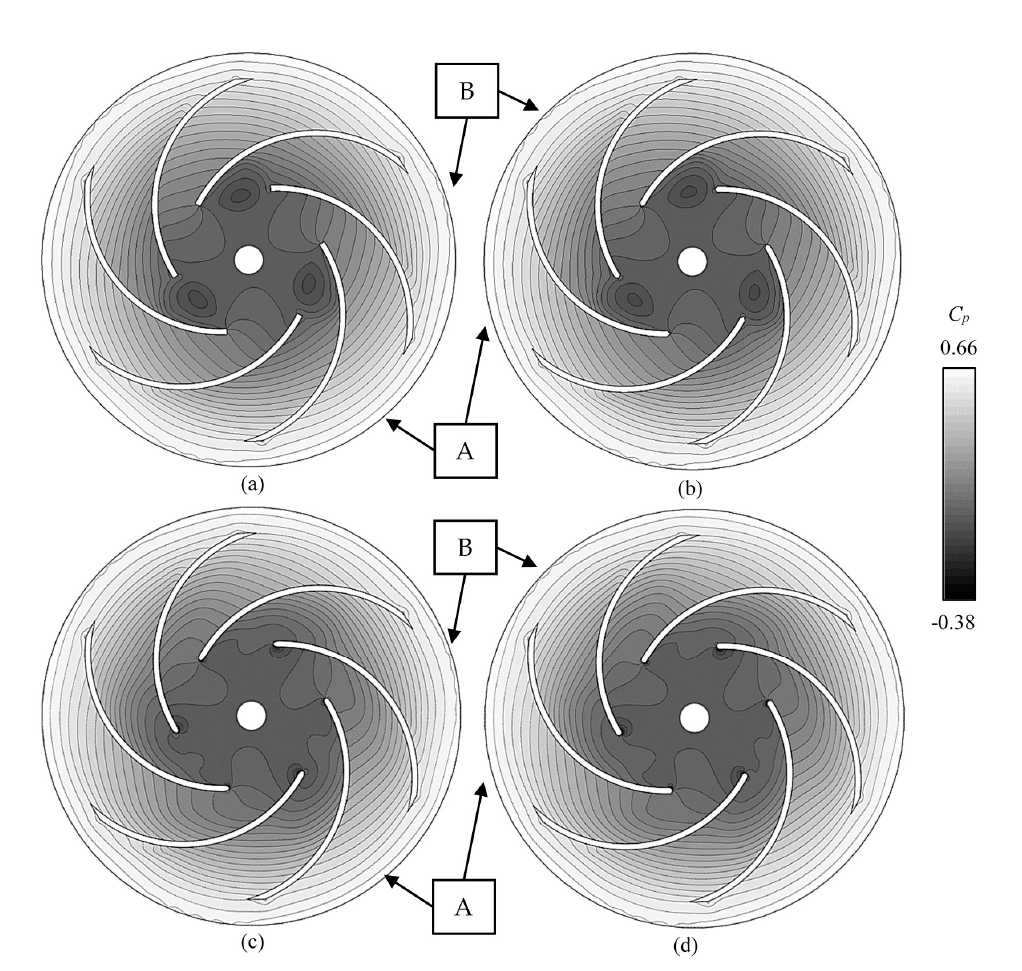
ffi cient, C p : ( a ) blunt, ( b ) sharp, ( c ) round, and ( d )